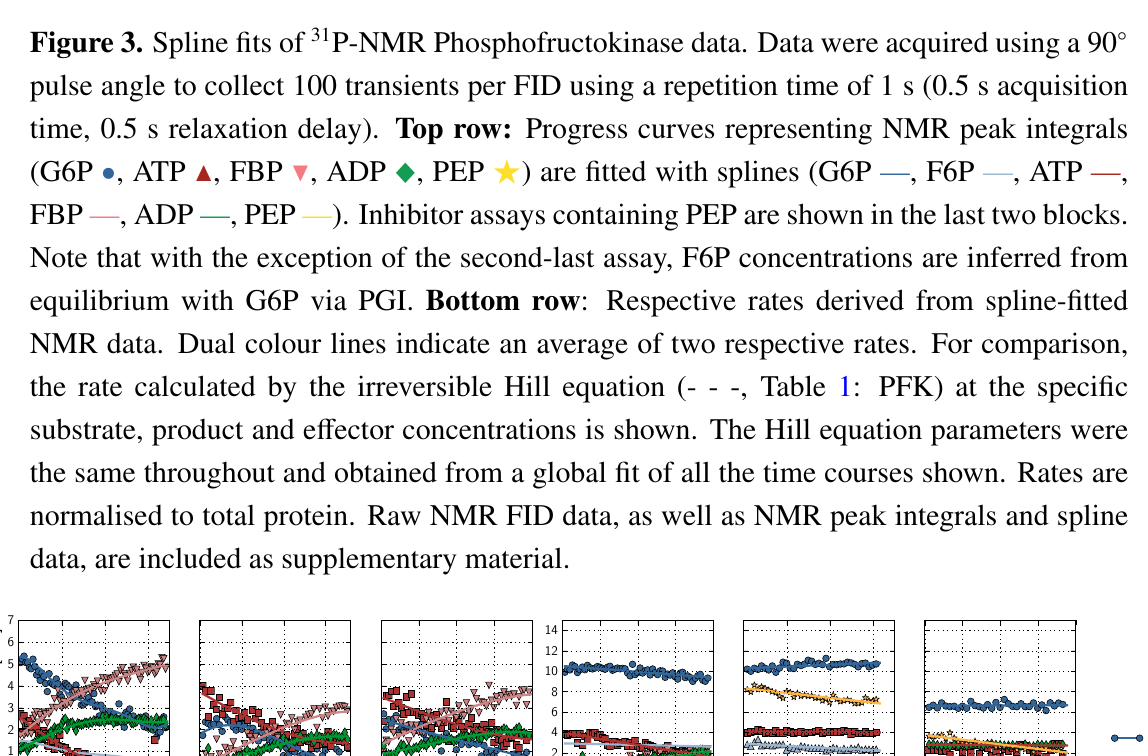
Figure 3. Spline fits of 31 P-NMR Phosphofructokinase data. Data were acquired using a 90 ◦